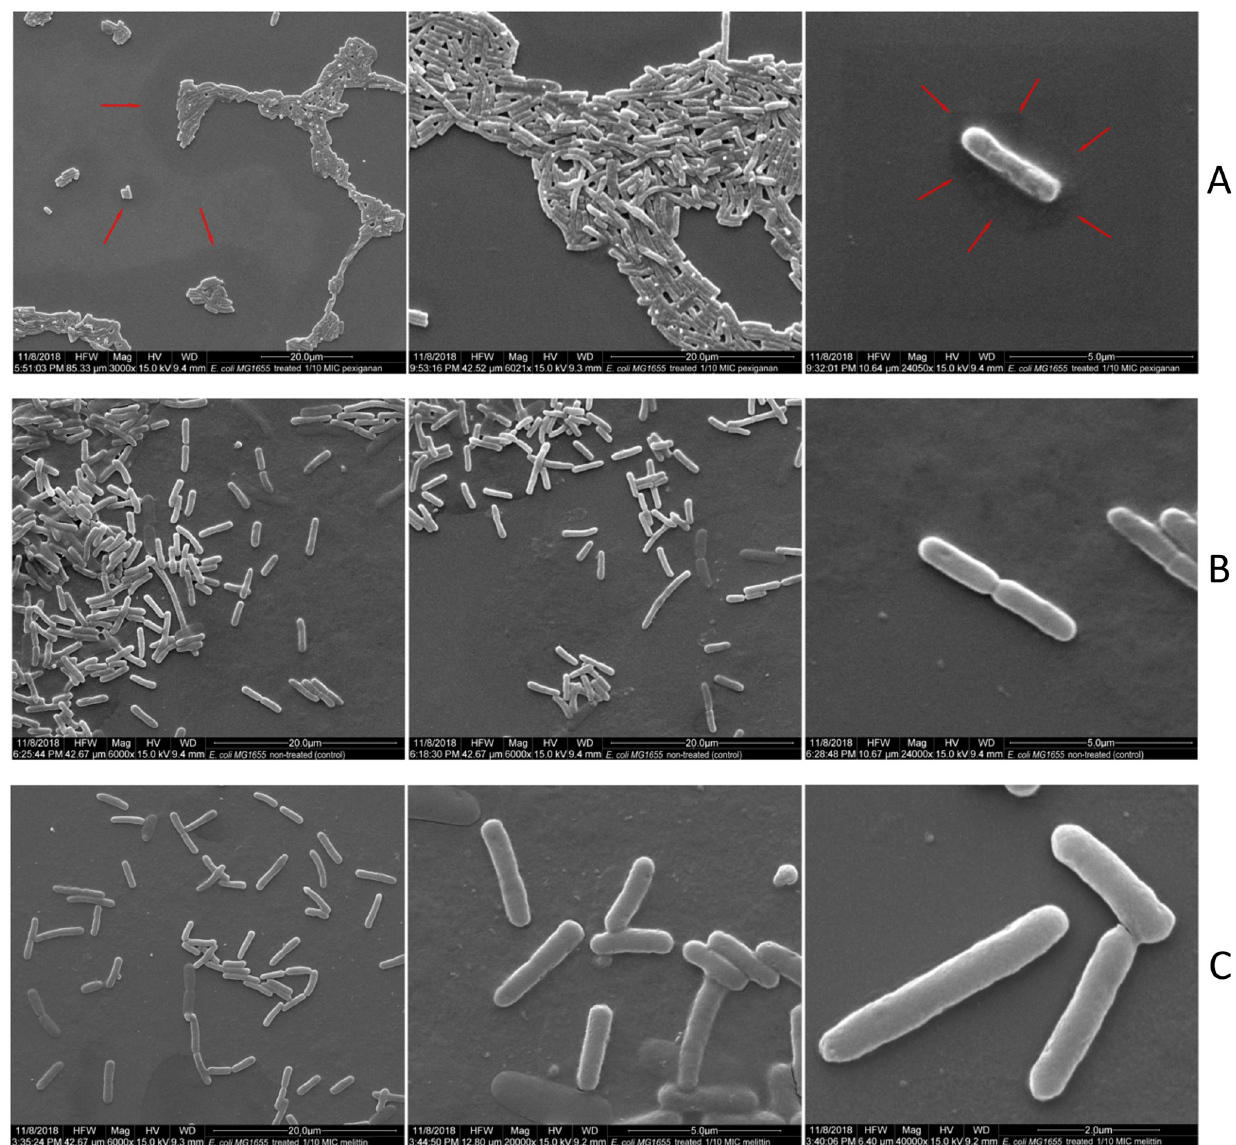
Fig 6. SEM of E . coli MG1655 treated with 1/10xMIC (priming concentration) of pexiganan (A) and melittin (B) and non-treated bacteria (B, middle row, control). Bacteria were treated with the AMPs for 30 minutes before sample fixation. No apparent differences were noticed between melittin-treated cells (C) and controls. In case of pexiganan, the treated cells tend to aggregate, a phenotype that is consistent with the presence of colanic acid. Red arrows indicate shadowed areas potentially produced by the capsule of colanic acid that collapse fixation and dehydration. Bacteria were observed with different magnifications ranging from 3000X to